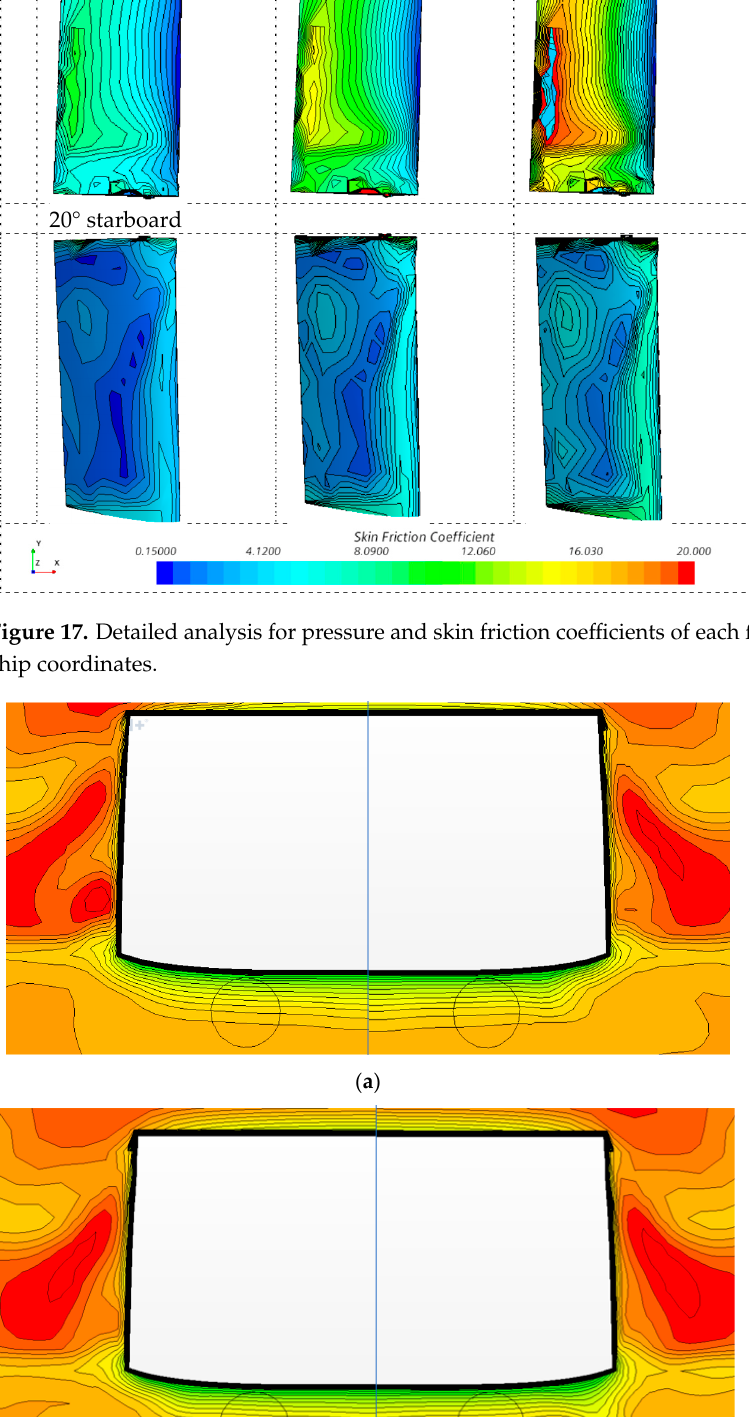
Figure 18. The wake fraction V axial /V ship distribution comparison at the propulsor disks at 18 kn. ( a ) Circumferential velocity distribution without fin ( left ) and with 0° fin ( right ). ( b ) with 20° fins.